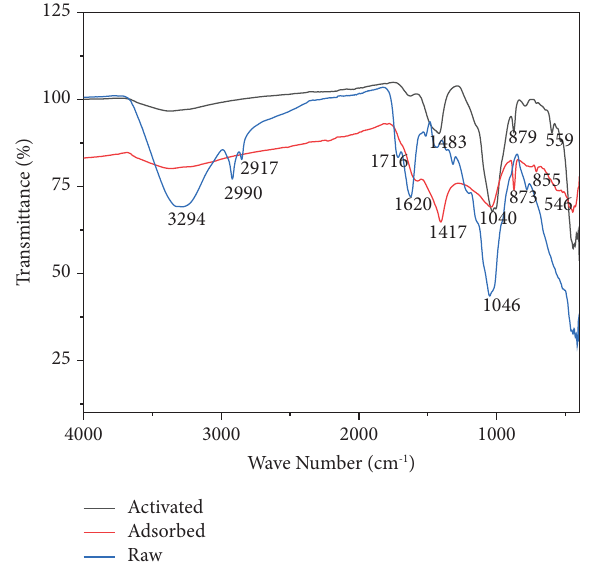
Figure 2: Some important peaks from FTIR analysis for raw precursor-activated carbon before adsorption and after adsorption.